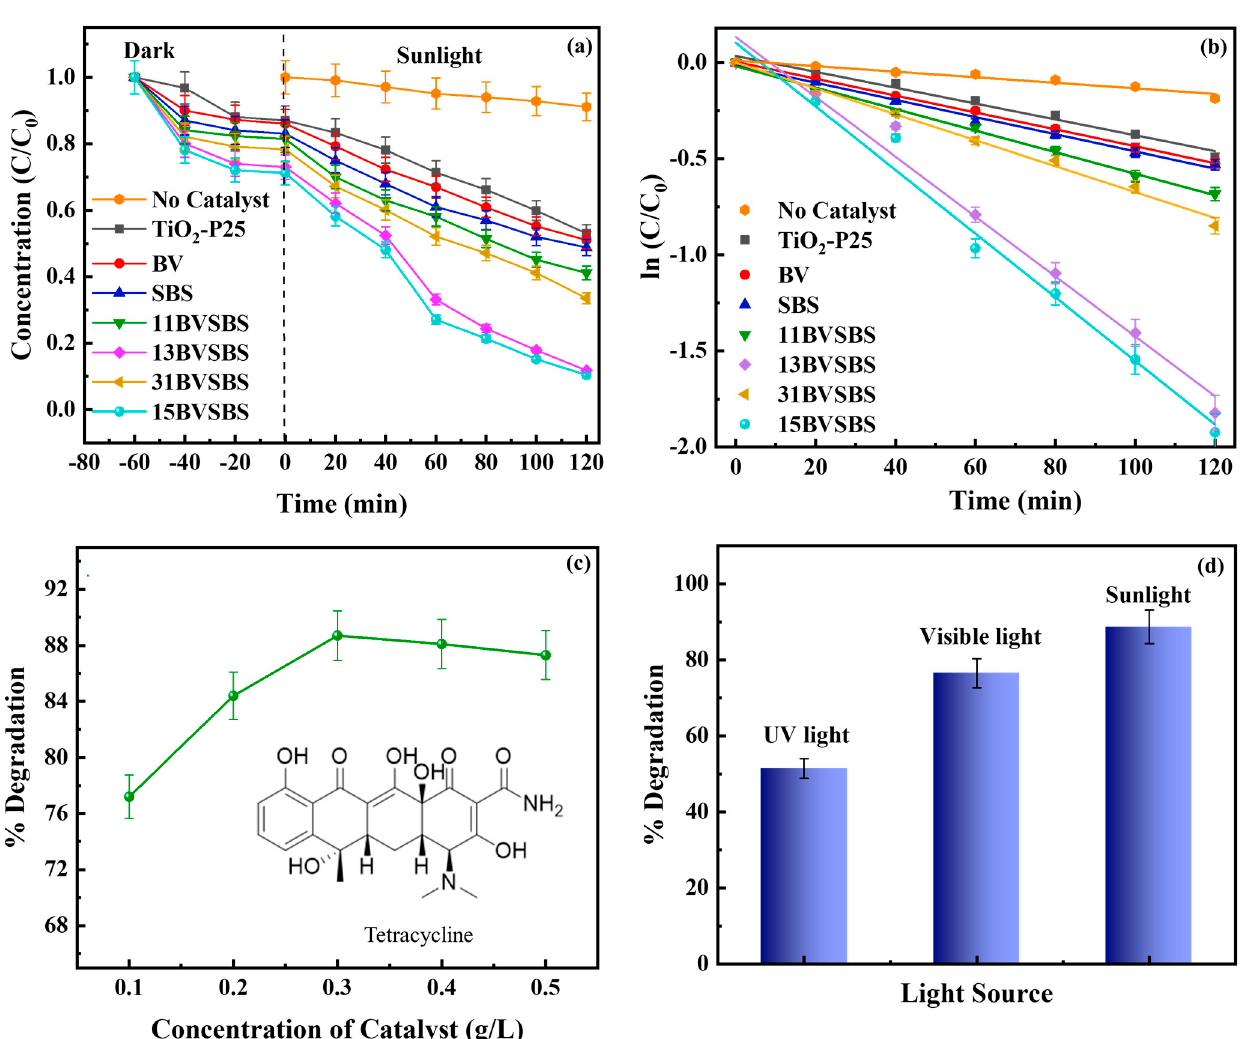
Figure 5. ( a , b ) Kinetic studies of the fabricated photocatalysts for the detoxification of TC, ( c ) concentration impact of the 13BVSBS photocatalyst, and ( d ) the effect of different light sources on the degradation efficiency of TC using the 13BVSBS photocatalyst.